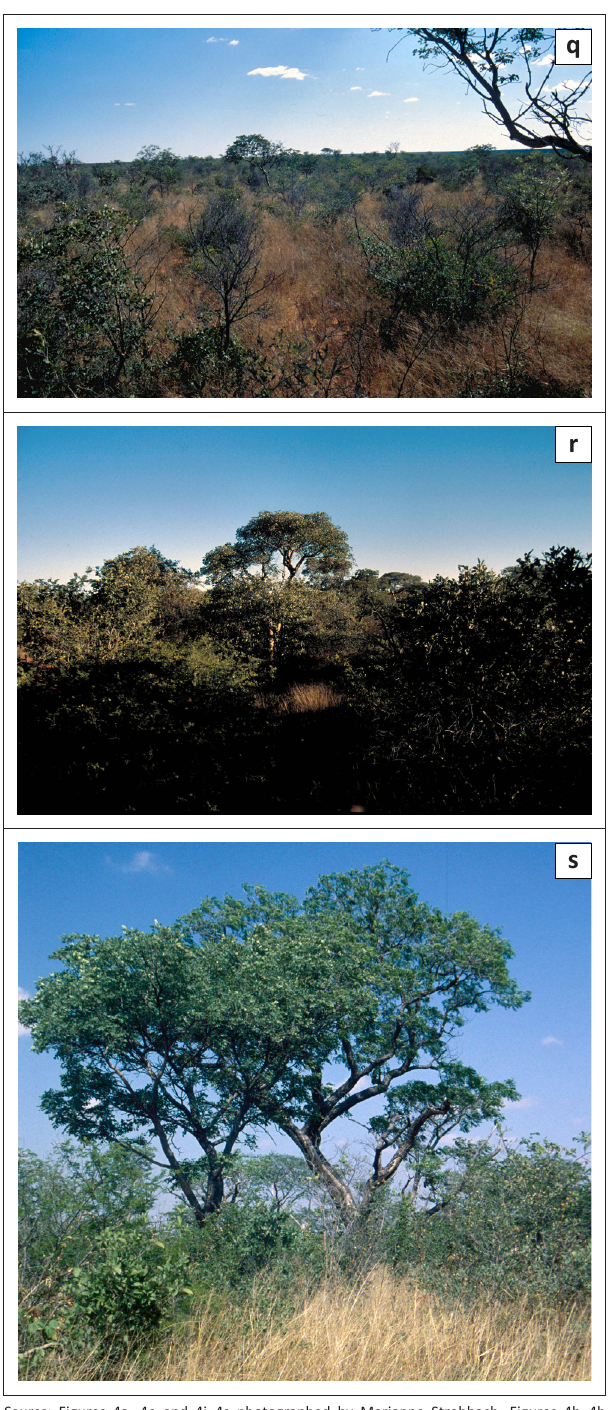
FIGURE 4 (Continues...): Typical examples of various associations and subassociations, (a) Acacio fleckii–Terminalietum prunioidis , (b) Acacio